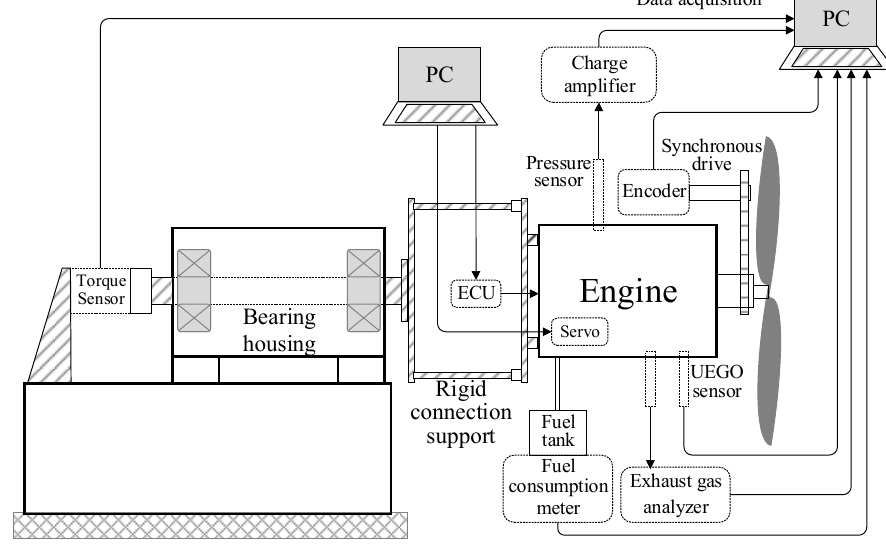
Figure 4. Schematic diagram of test bench.